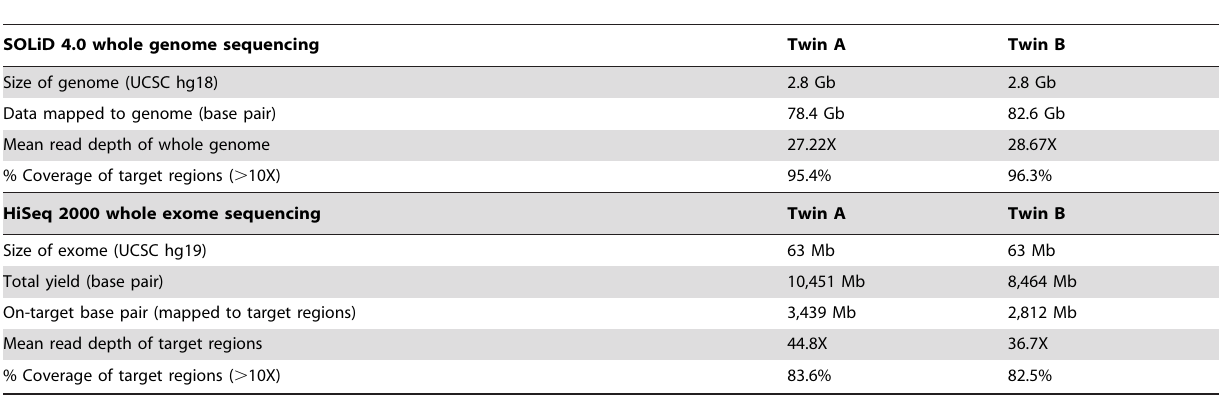
Table 1. Summary of sequencing results from whole genome and exome sequencing data.